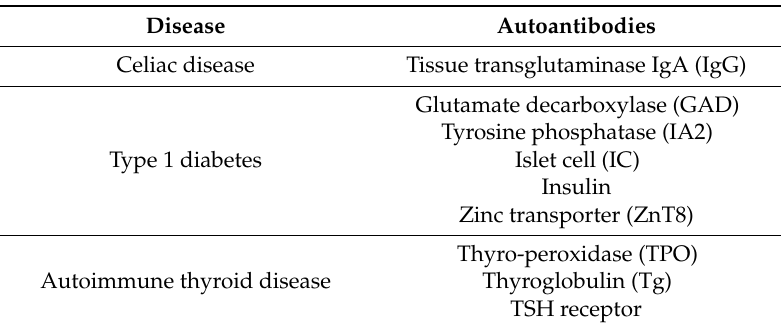
Table 1. Autoimmune disease specific